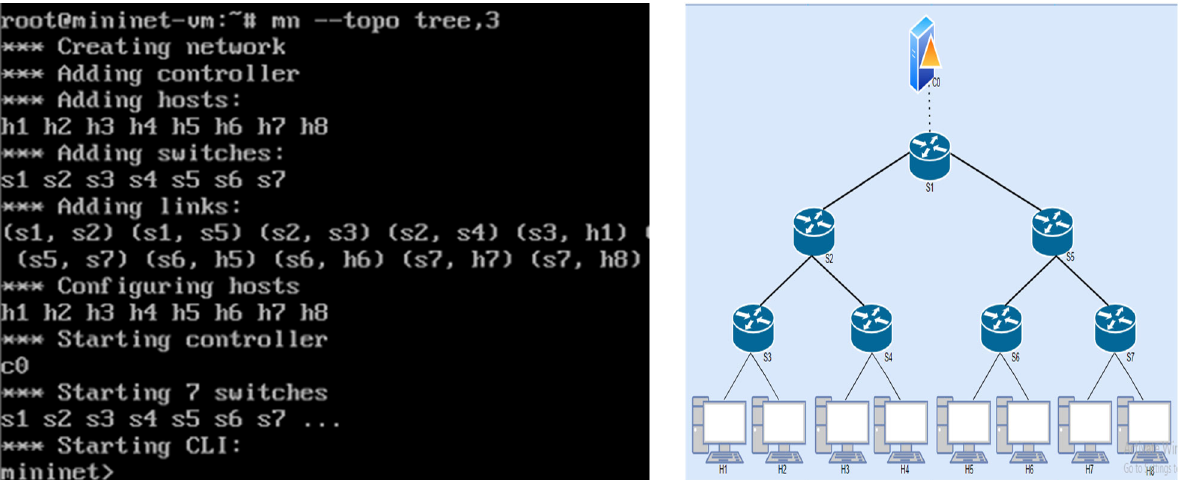
Figure 17. Tree topology Mininet command: mn ‐‐ topo tree,3.